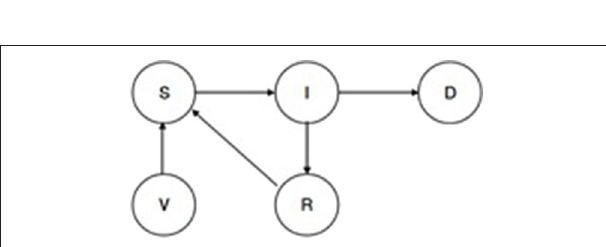
FIGURE 4 | SIRV epidemiological transmission model.